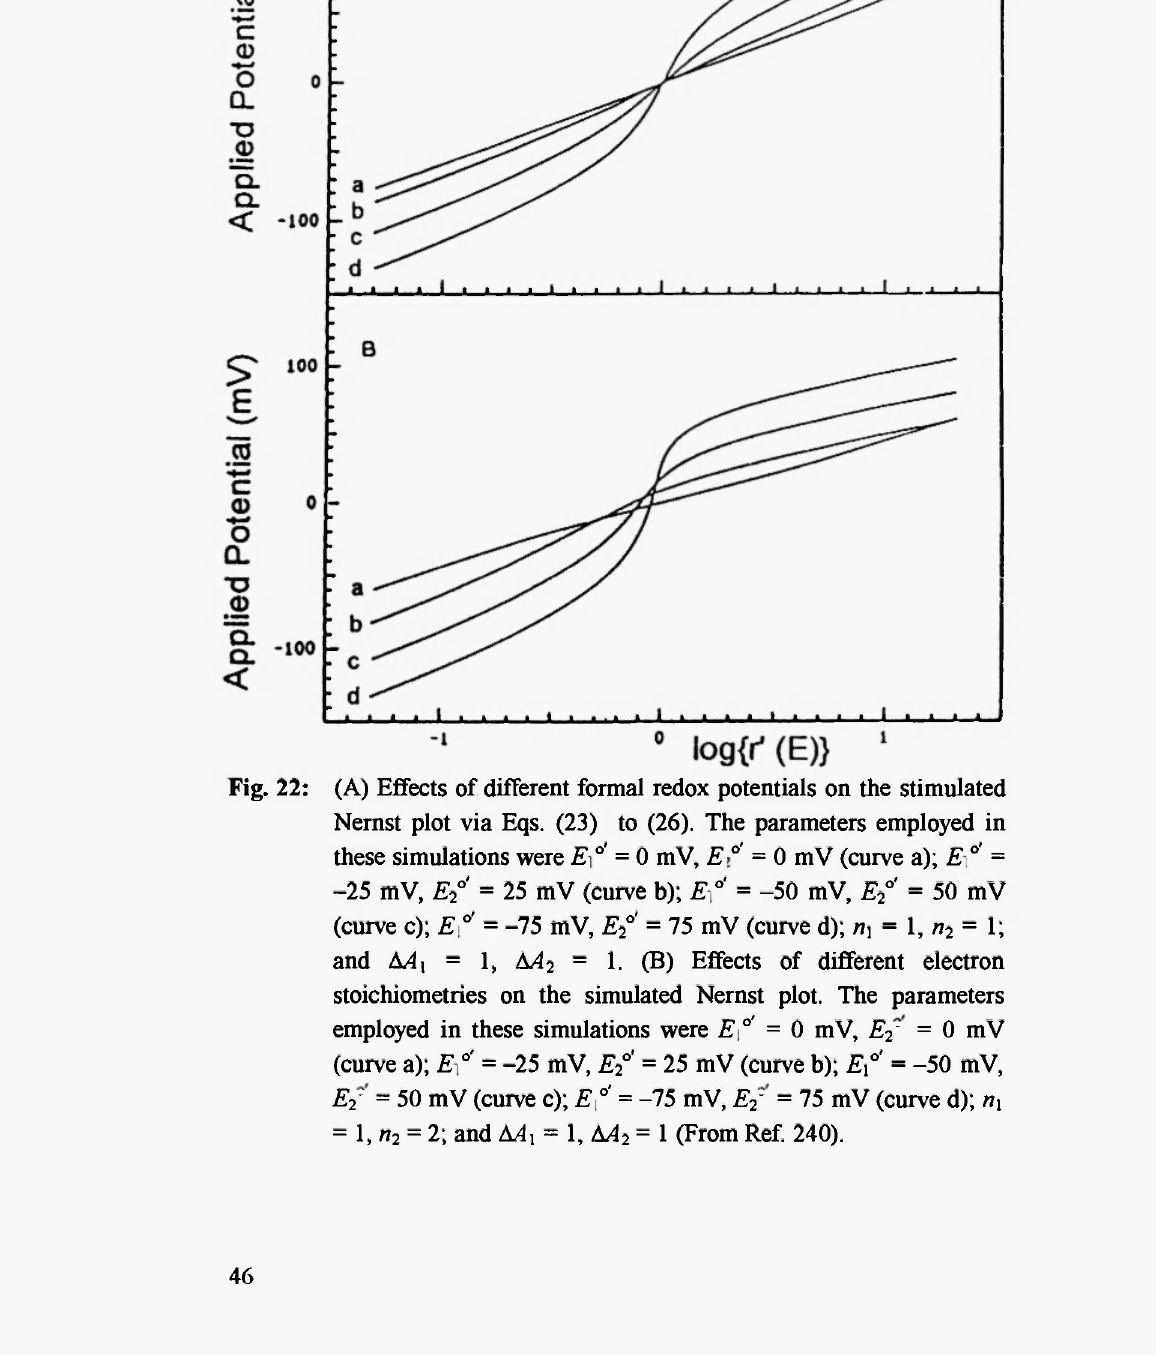
Fig. 22: (A) Effects of different formal redox potentials on the stimulated Nernst plot via Eqs. (23) to (26). The parameters employed in these simulations were E°' = 0 mV, E°' = 0 mV (curve a); E°' = -25 mV, E °' = 25 mV (curve b); E°' = -50 mV, E °' = 50 mV 2 2 (curve c); E°' = -75 mV, E °' = 75 mV (curve d); = 1, n = 1; 2 2 and AA = 1, AA = 1. (B) Effects of different electron l 2 stoichiometrics on the simulated Nernst plot. The parameters employed in these simulations were E°' = 0 mV, E = 0 mV 2 (curve a); E°' = -25 mV, E °' = 25 mV (curve b); E °' = -50 mV, 2 x E = 50 mV (curve c); E°' = -75 mV, E = 75 mV (curve d); n 2 2 x = \,n = 2; and Δ^ι = 1, AA = 1 (From Ref. 240). 2 2